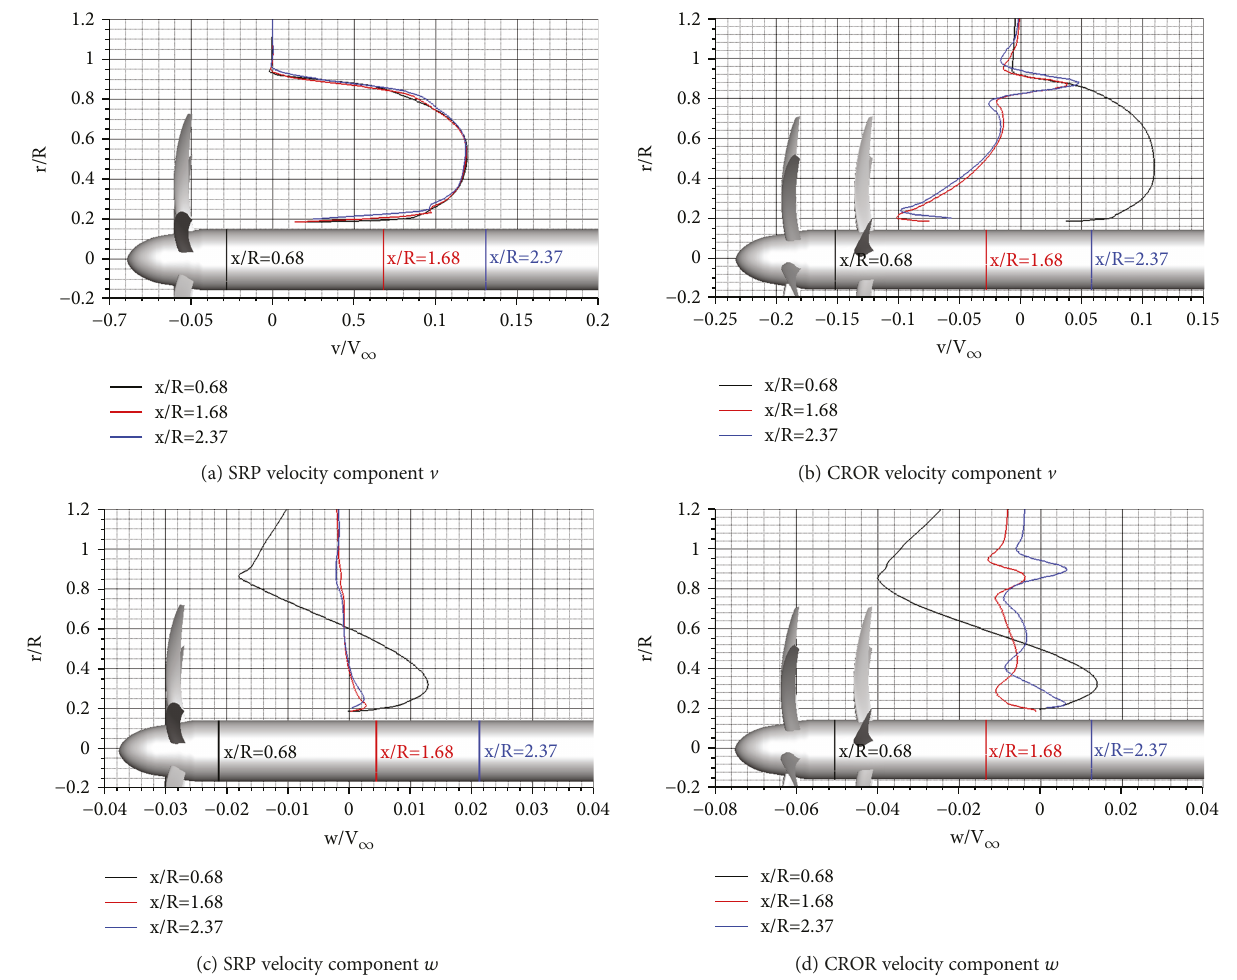
Figure 15: Time-averaged slipstream-normalized velocity pro fi les; J = 1 73779